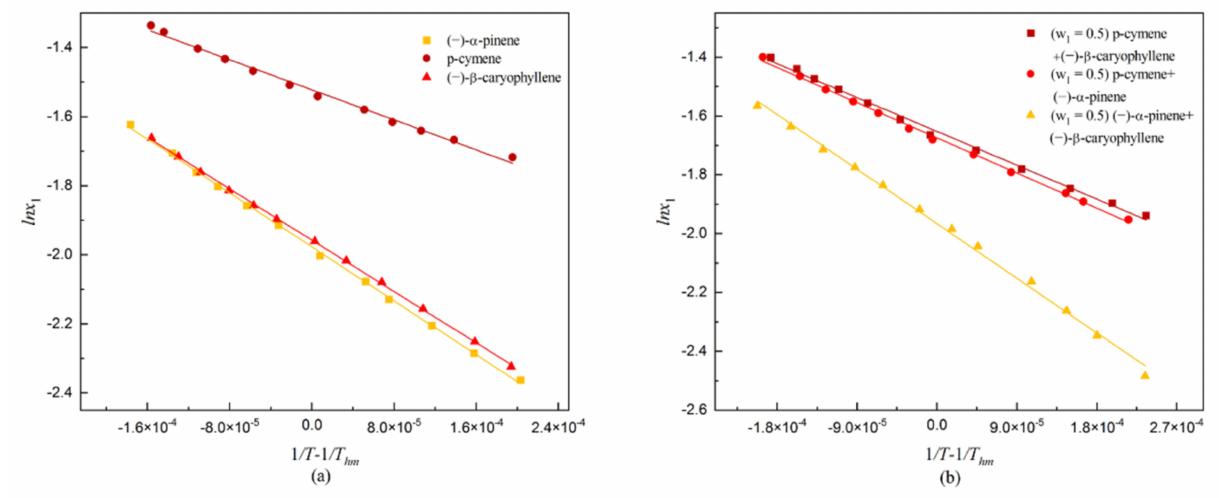
Figure 6. Plot of ln x 1 against 1/ T − 1/ T hm for dehydroabietic acid in selected solvents: ( a ) indicates in monosolvents; ( b ) indicates in mixed